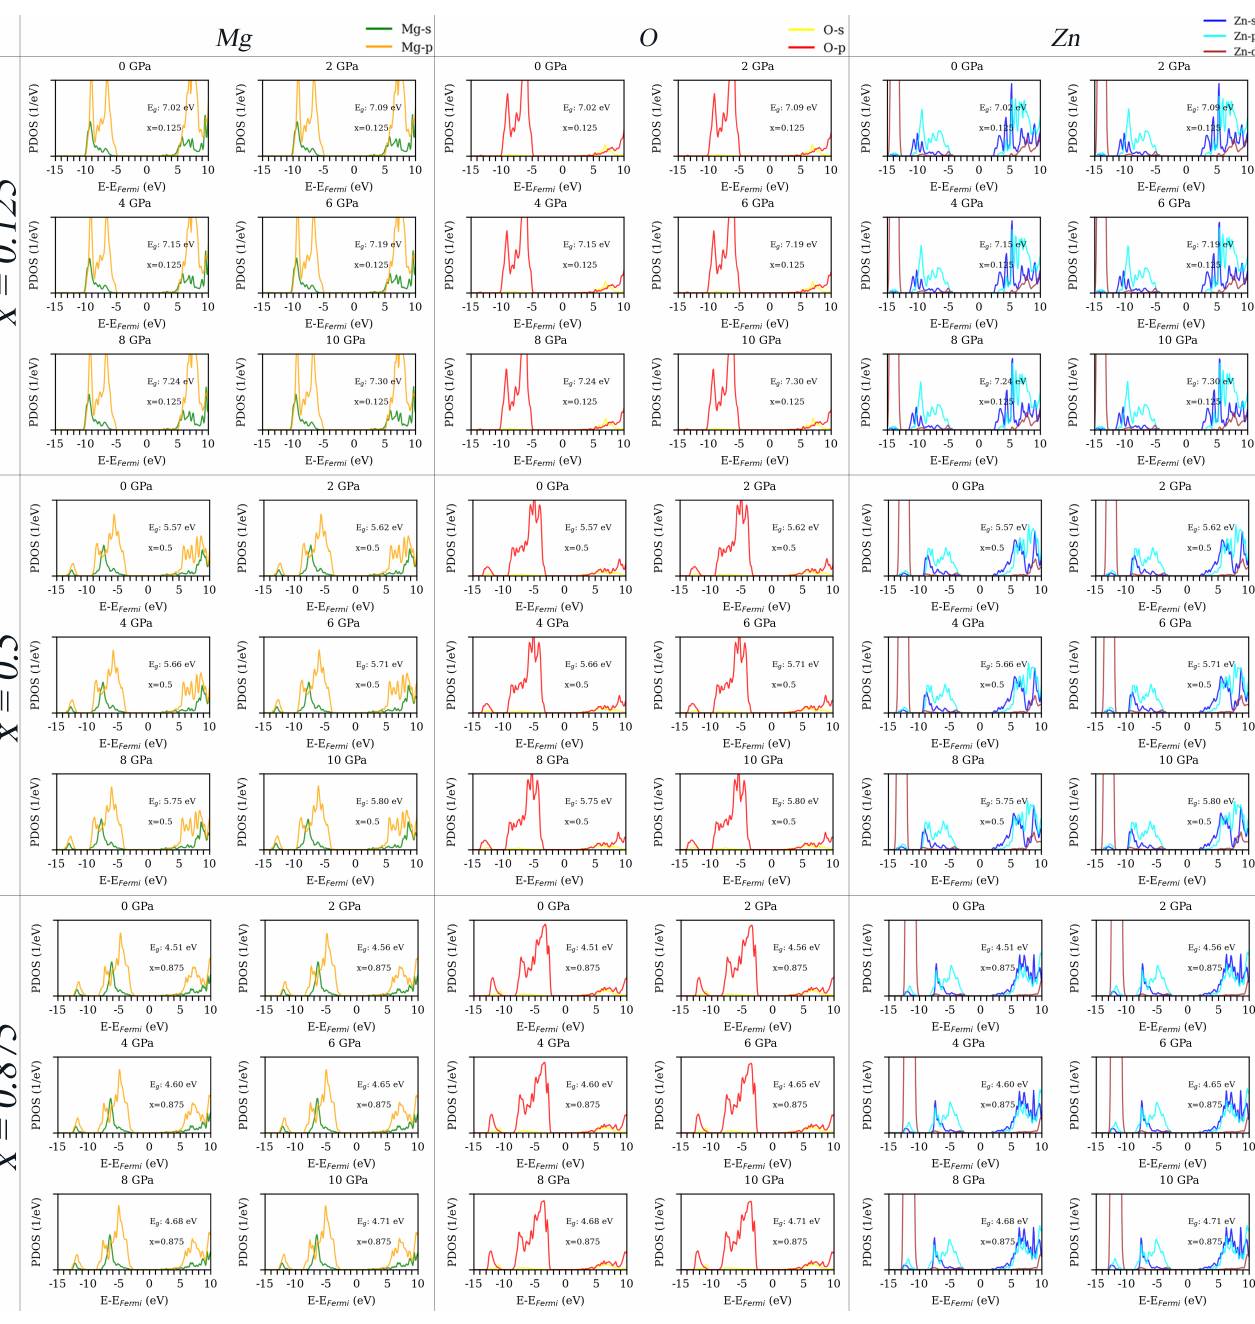
Figure A1. Partial density of states (PDOS) of rocksalt (RS) Mg 1 − x Zn x O for RS ZMO models at different concentration (x = 0.125, 0.5 and 0.875) with the pressure from 0 to 10 GPa in 2 GPa increments, which correspond to Figure